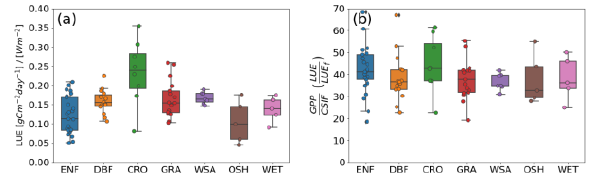
Figure 8. LUE (a) and the ratio between GPP and CSIF (b) according to biome